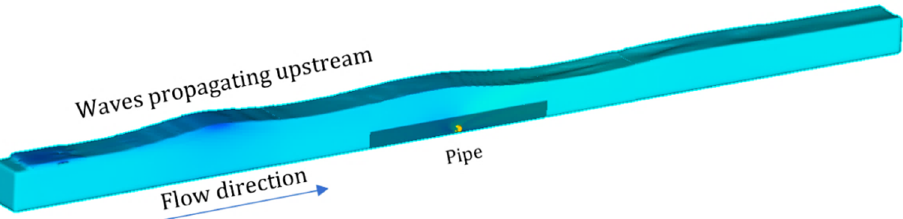
Figure 26. Back-water effect in a channel with sub-critical flow.